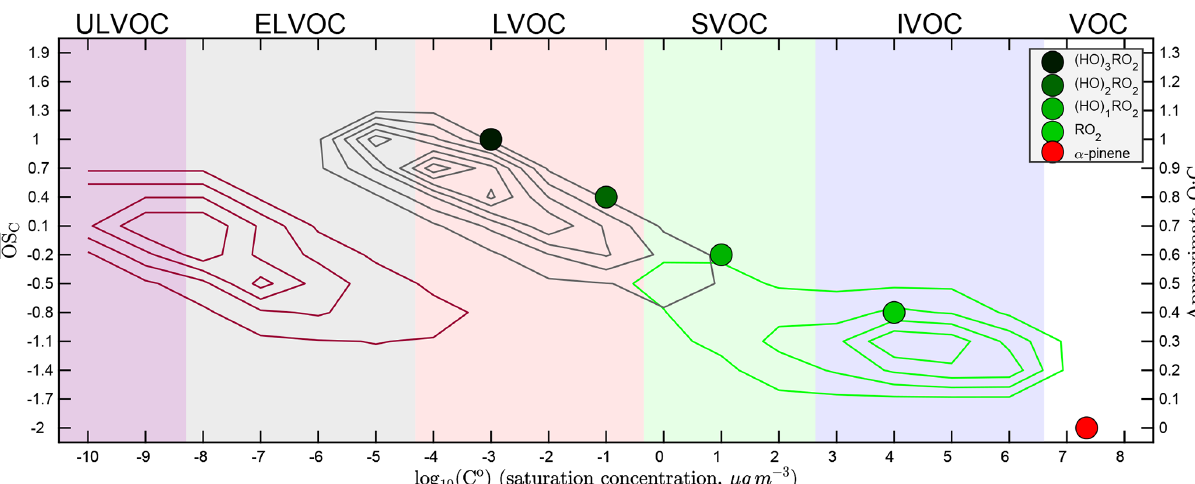
Figure 1. Basic α -pinene oxidation and the two-dimensional volatility basis set (2D-VBS), including explicitly treated peroxy radicals (RO 2 ). Axes are volatility log 10 C ◦ ( 300K ) and O:C. Broad colored bands are volatility classes, indicated along the top: ULVOCs are efficient nucleators. α -Pinene (red, lower right) oxidizes to produce a succession of peroxy radicals – first a traditional radical (RO 2 , in light green) and then a succession of oxidized RO 2 via autoxidation (Ox n RO 2 , darker shades of green). RO 2 radicals ultimately terminate into molecular products, represented here by contours depending on whether they derive from the traditional RO 2 (green contours), autoxidation (C 10 monomers, gray contours), or Ox n RO 2 dimerization (C 20 ROOR, maroon contours).